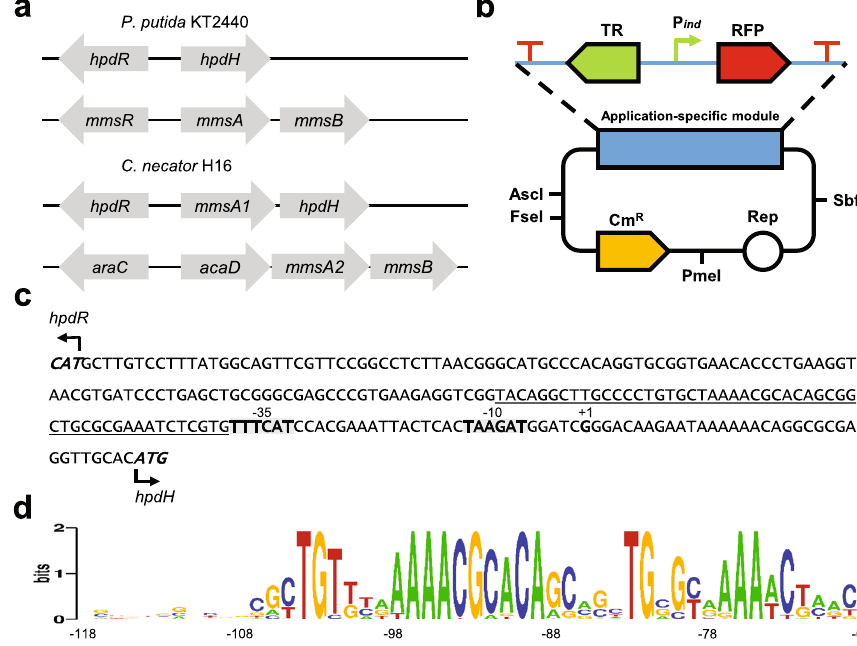
Figure 1. Identification of putative 3-HP-responsive genes in P. putida KT2440 and C. necator H16. ( a ) Operons putatively involved in 3-HP metabolism in P. putida KT2440 and C. necator H16. They are composed of the TR coding sequences hpdR , mmsR or araC , and divergently transcribed genes which are putatively required for 3-HP degradation: hpdH , 3-hydroxypropionate dehydrogenase; mmsA , methylmalonate- semialdehyde dehydrogenase; mmsB , 3-hydroxyisobutyrate dehydrogenase and acaD , acyl-CoA dehydrogenase. ( b ) Schematic illustration of the modular reporter system. It contains the four unique restriction sites AscI, FseI, PmeI and SbfI which are used for modular assembly. The application-specific module harbours the rfp reporter gene and the switchable system composed of transcriptional regulator and inducible promoter. ( c ) The P. putida KT2440 hpdR / hpdH intergenic region. Translational start sites are bold and italicised. The predicted hpdH − 35 and − 10 regions are bold and highlighted in grey. The nucleotide sequence between position − 118 and − 68 relative to the P. putida KT2440 hpdH translational start site is underlined. ( d ) A sequence similarity motif was generated which corresponds to the underlined sequence. It represents highly conserved nucleotides in the hpdR / hpdH intergenic regions of forty analysed Pseudomonas